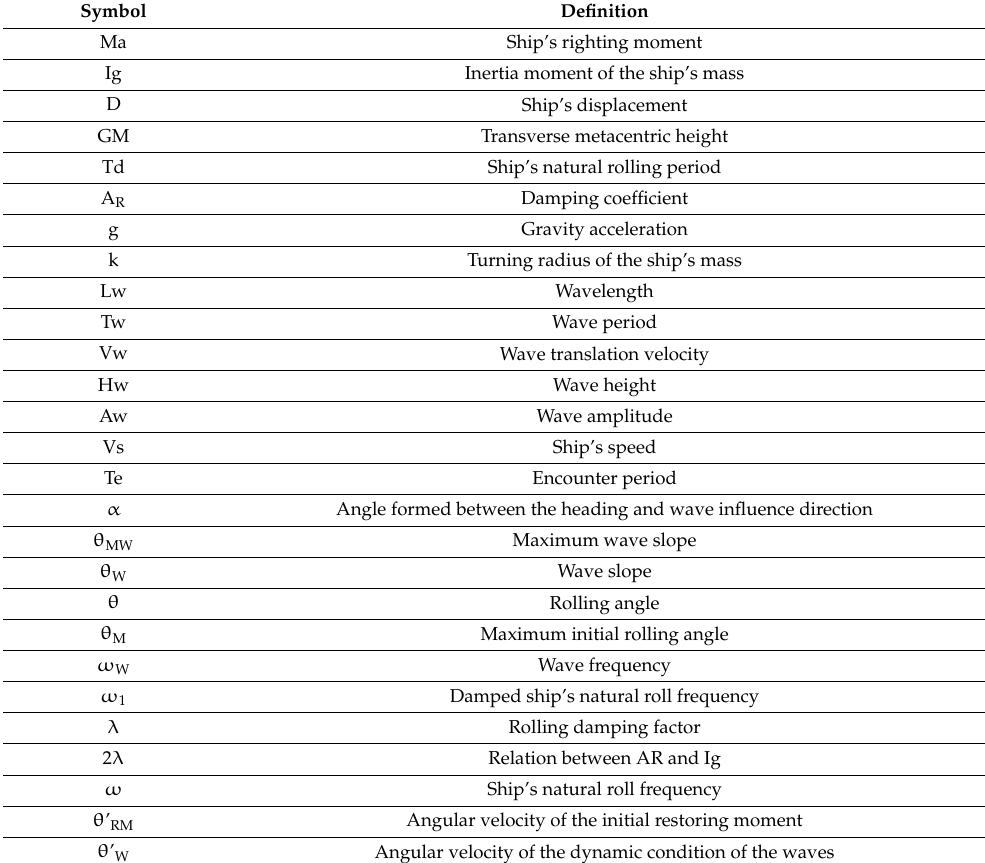
Table A1. Symbols and their